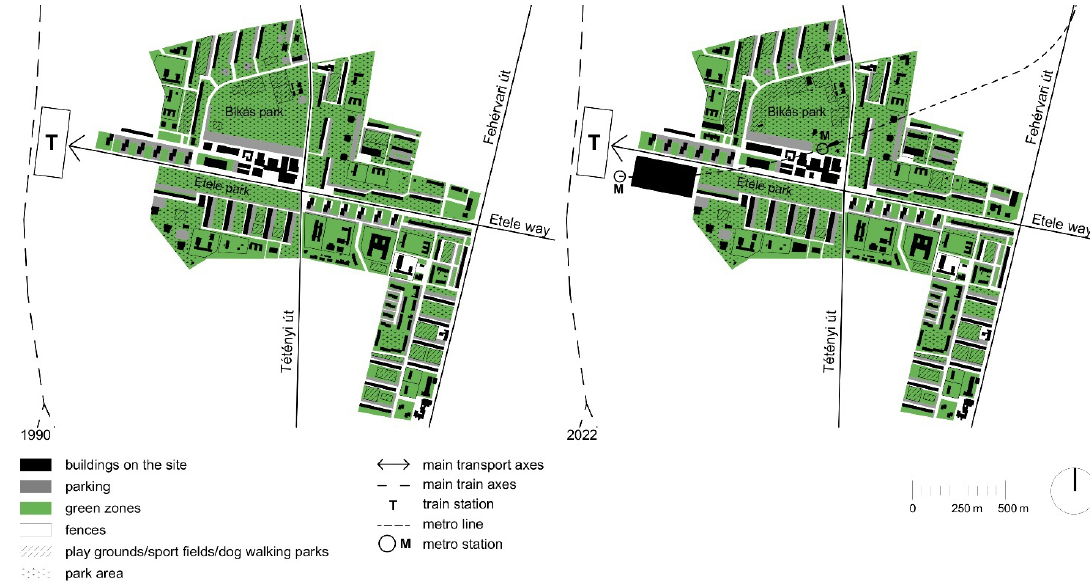
Figure 11. Kelenföld open space in 1990 and 2022 (source: